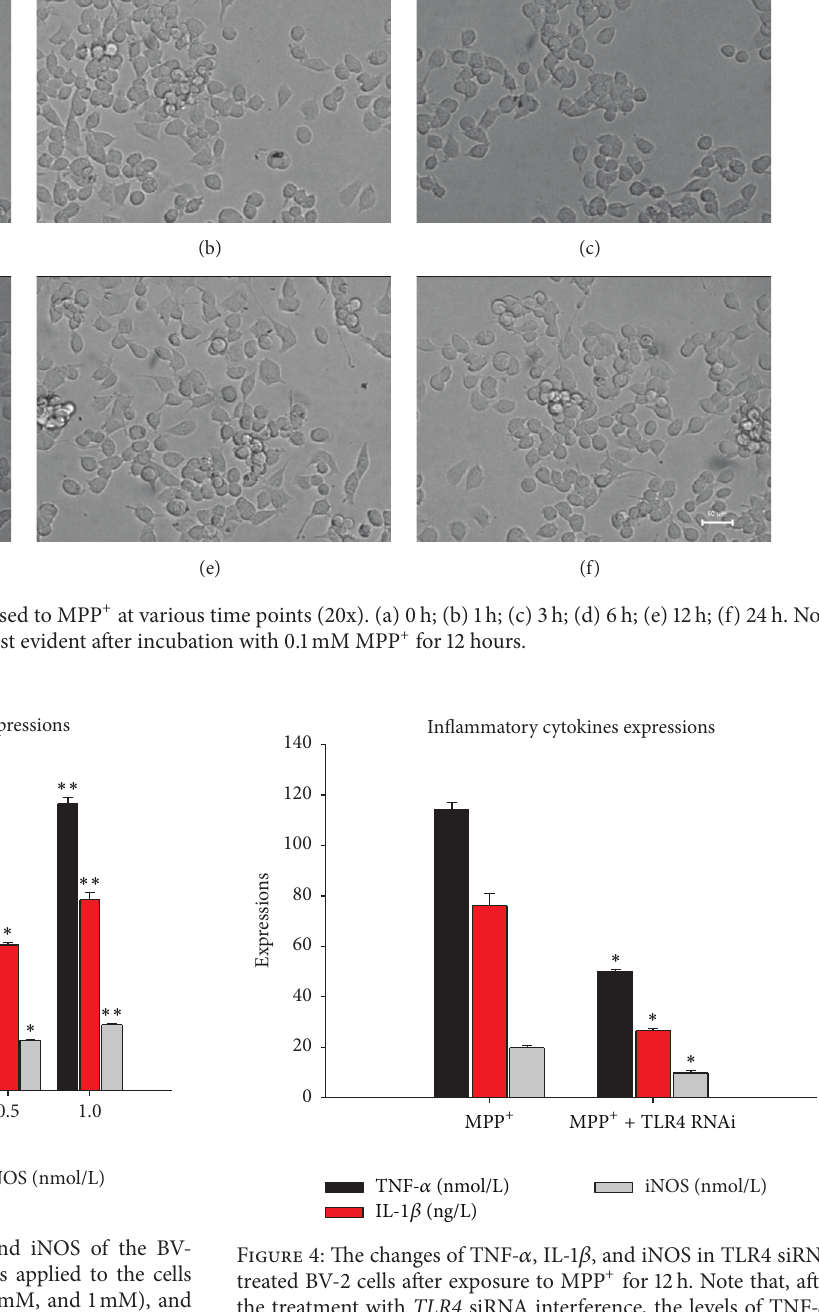
group, which also suggested that the BV-2 cells were activated.